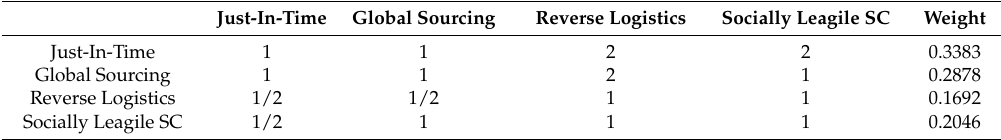
Table A10. Pairwise Comparison of Alternative w.r.t. sub-criterion Production Quality.